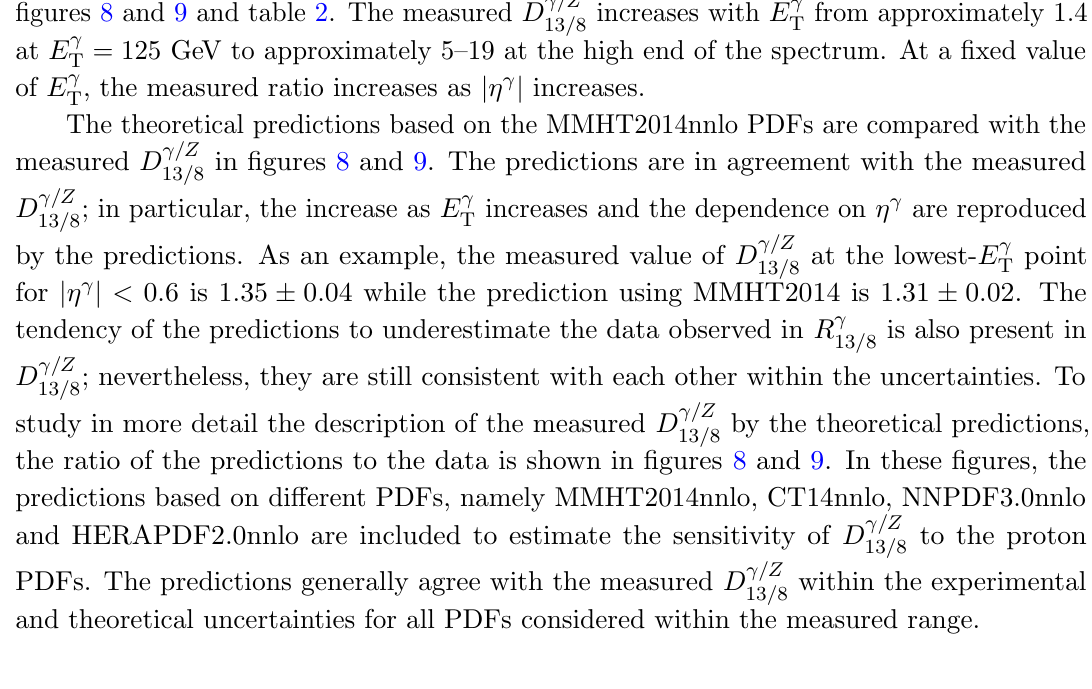
Table 2 . The measured D (cid:13)=Z uncertainty in di(cid:11)erent regions of j (cid:17) (cid:13) j